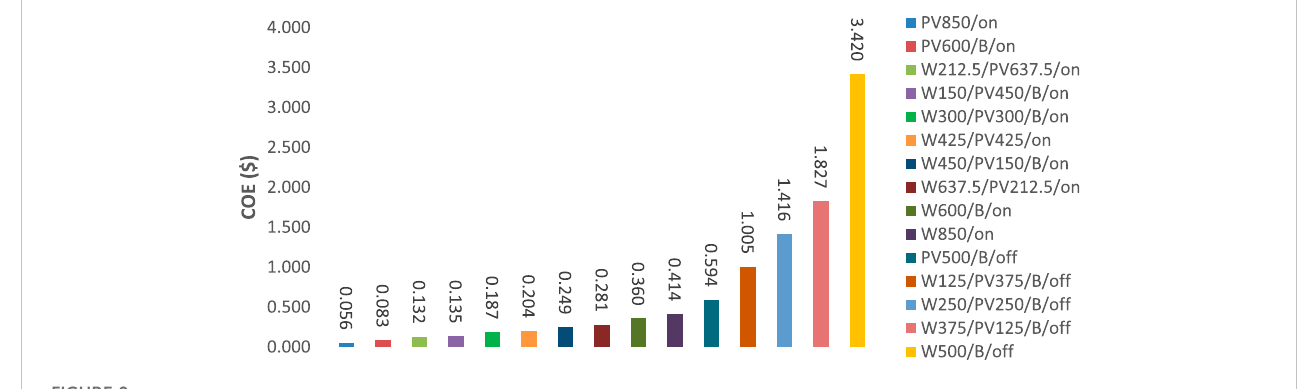
FIGURE 9 Cost of energy of all